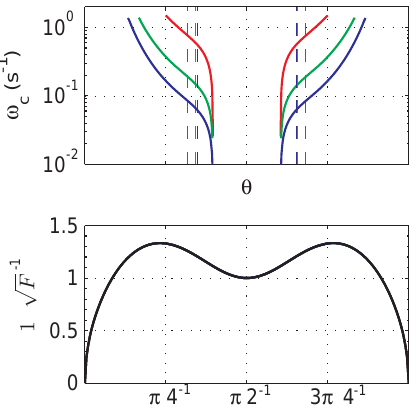
Figure 7. The parameters ω c and f (θ) for the poloidal standing Alfvén waves of the dipole field. Format is the same as Fig. 1.